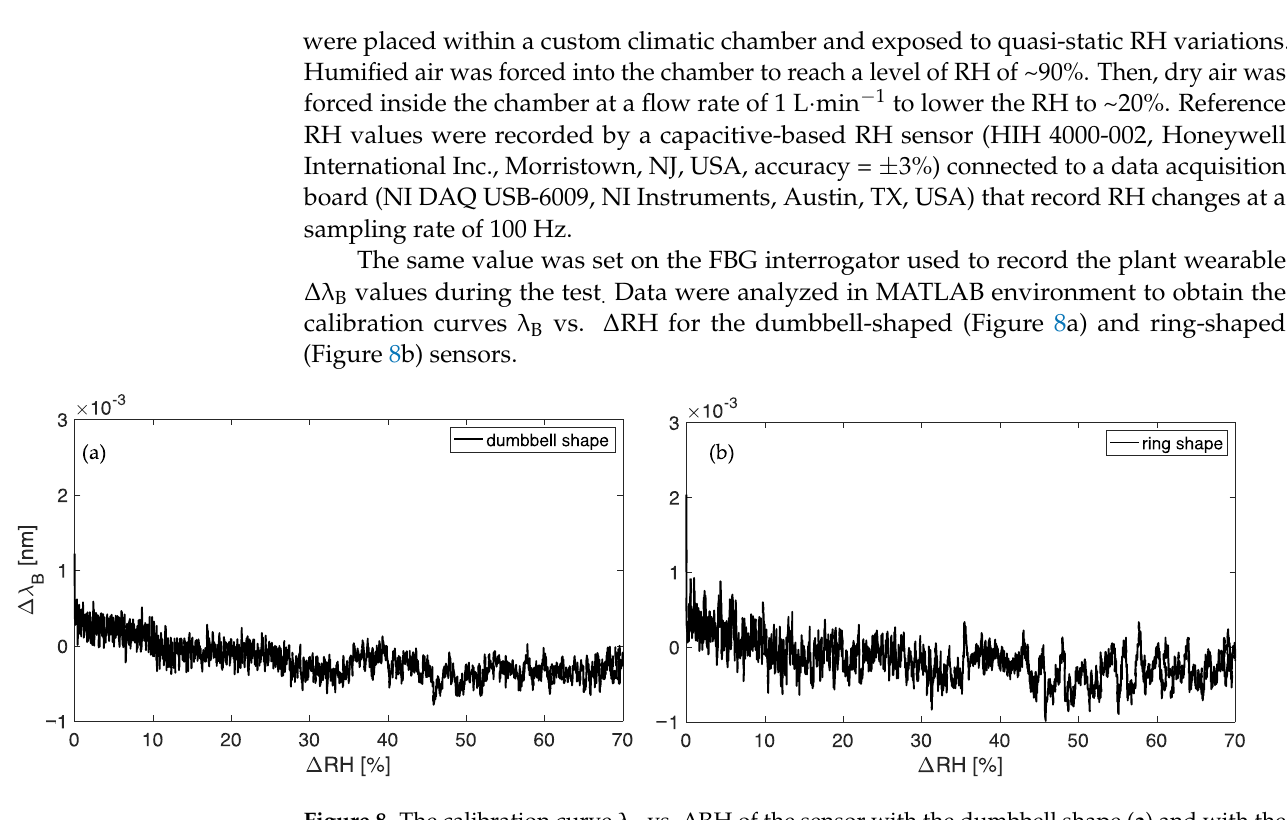
Figure 8. The calibration curve λ B vs. ∆ RH of the sensor with the dumbbell shape ( a ) and with the ring shape ( b ).